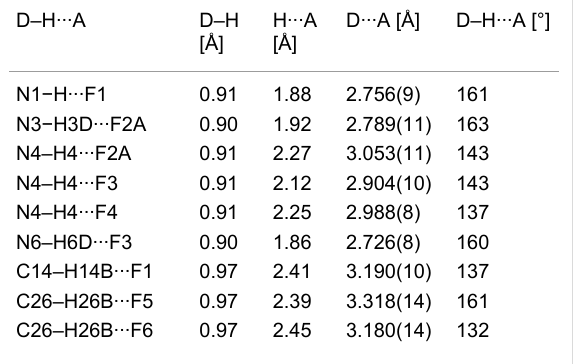
Table 7: Selected hydrogen-bond lengths (Å) and bond angles (°) of complex 3 .